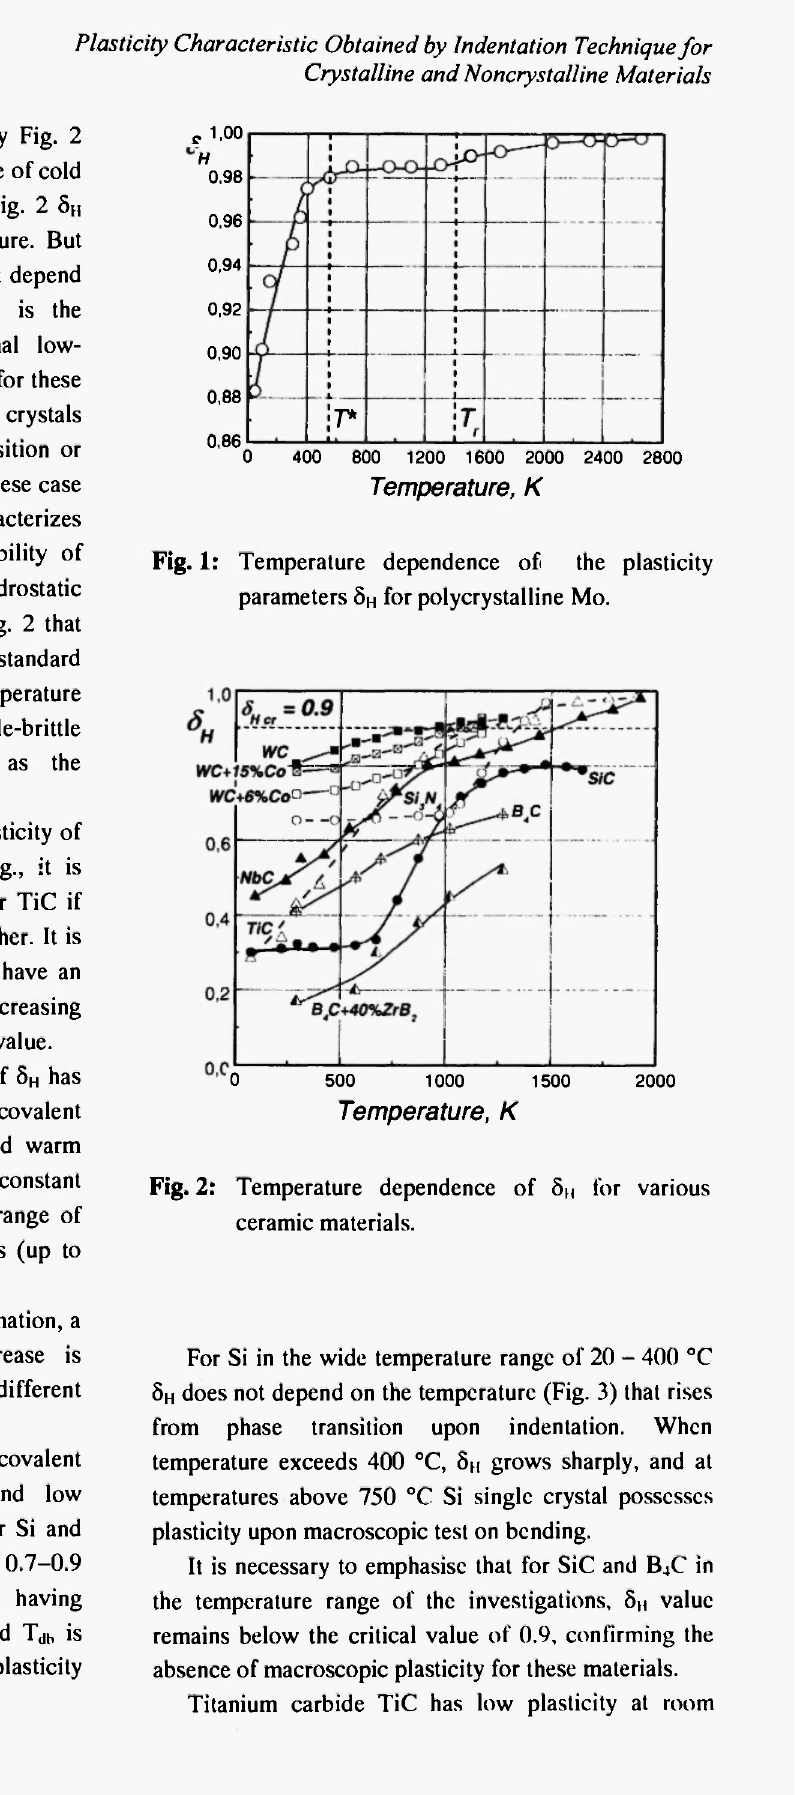
Fig. 2: Temperature dependence of δμ for various ceramic